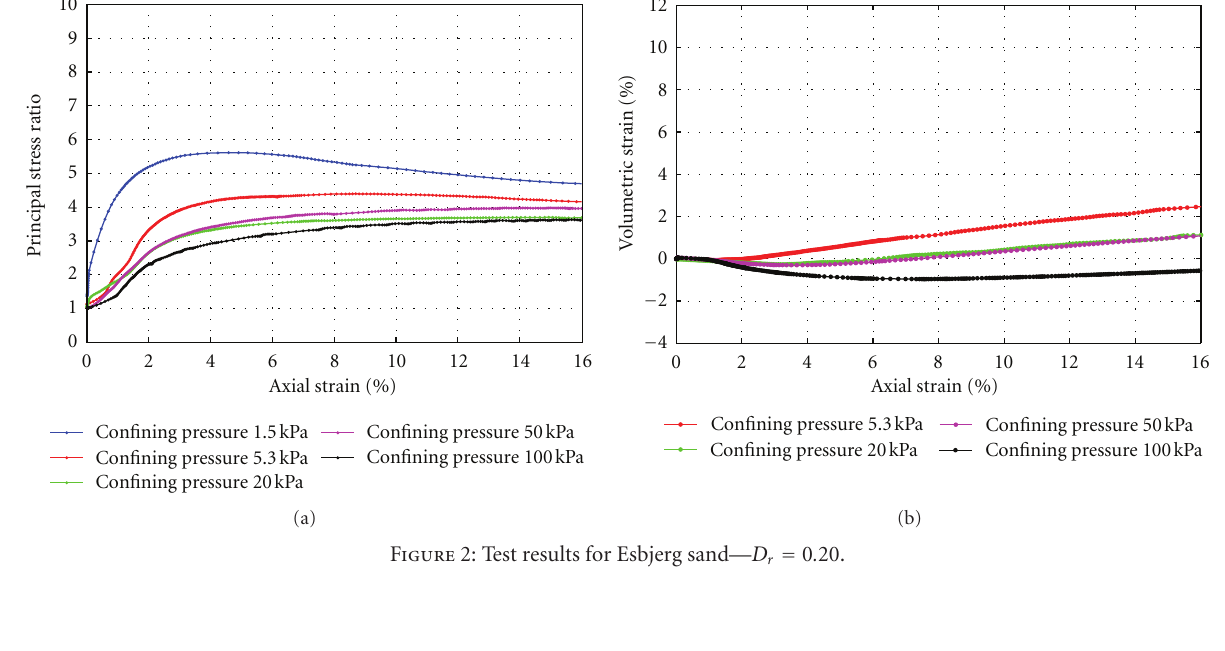
Figure 2: Test results for Esbjerg sand— D r = 0 . 20.